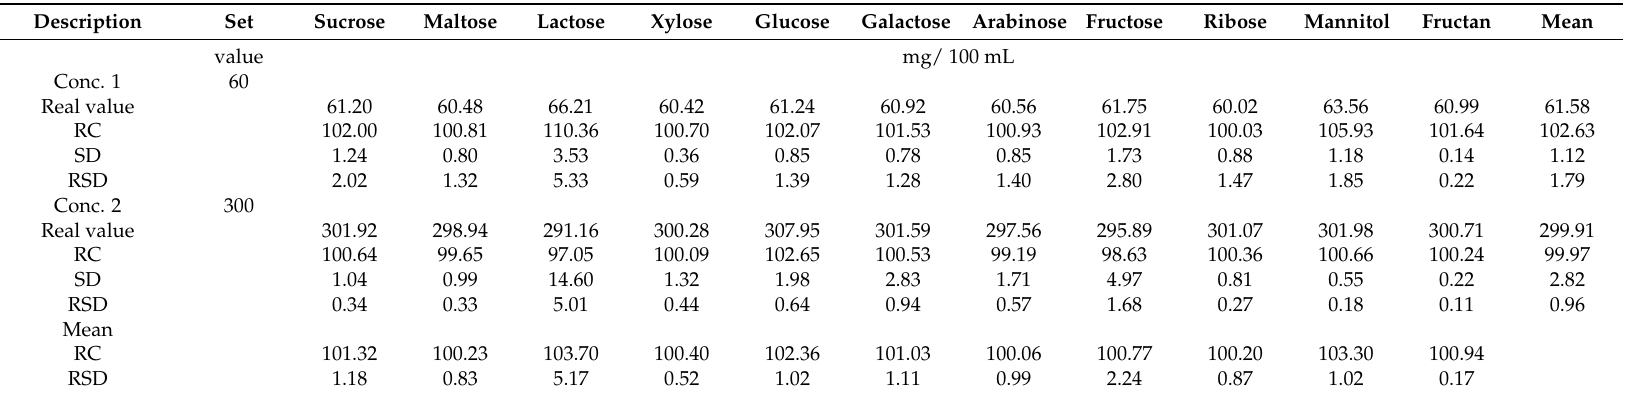
Table 4. Recovery rate (RC, %), absolute (SD) and relative (RSD, %) standard deviation of two model solutions (conc. 1: 60 mg/100 mL and conc. 2: 300 mg/100 mL), measurements performed on one day ( n = 10).